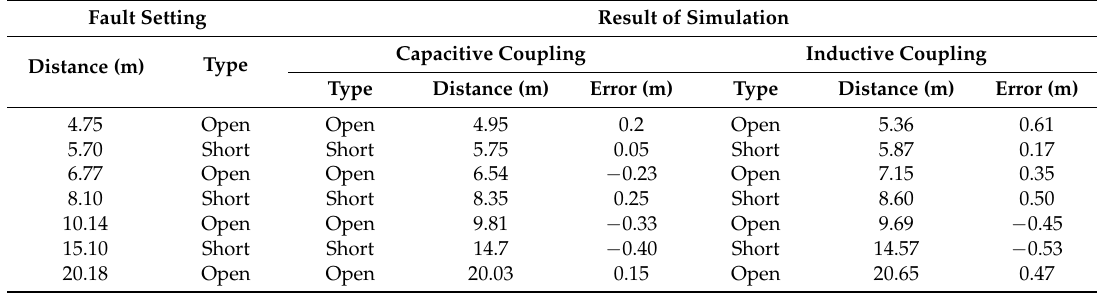
Table 1. Statistical results of the simulation.